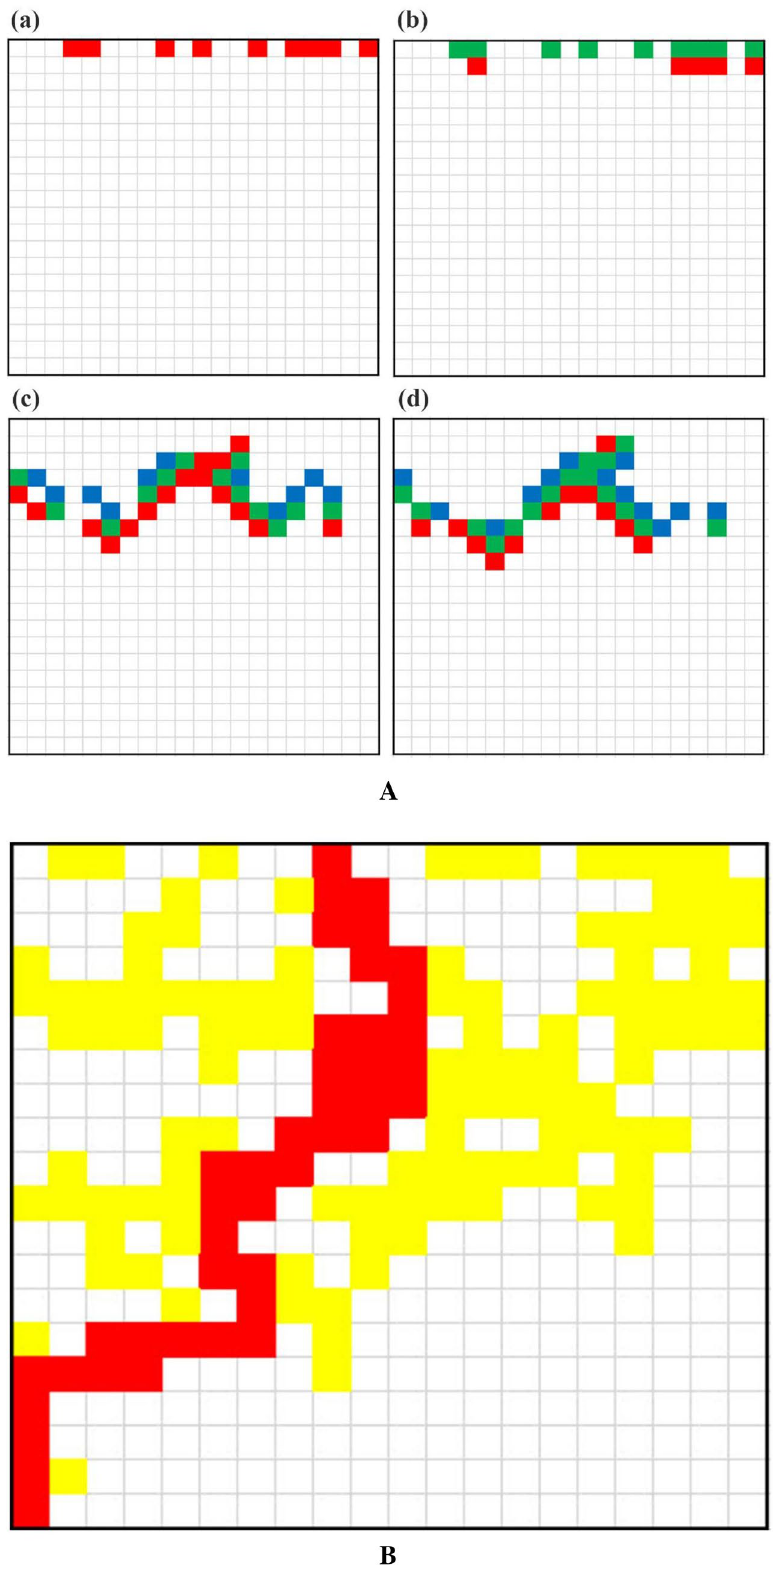
Figure 1. ( A ) Several generations of a typical case: Matrix 20 × 20, p = 60%. Generations presented: (a)-1, (b)-2, (c)-8 and (d)-9. Cells of type 1 are in red; those of type 2 in green; and those of type 3 in blue. ( B ) Exemplary active-cells through-path (in red) near percolation. Matrix 20 × 20, p = 60%. Other active cells during process are in